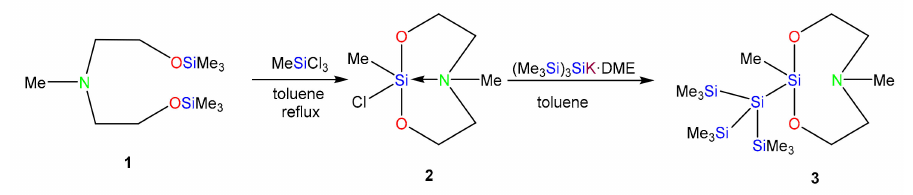
Scheme 2. Preparation of oligosilanylated silocane compound 3